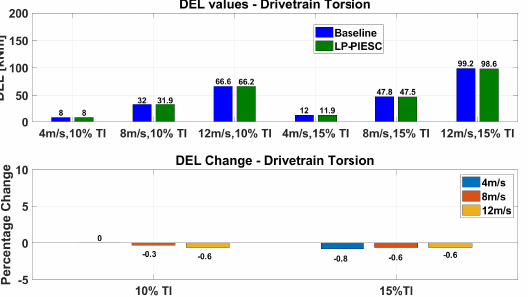
Figure 15. Drivetrain torsion comparison: Baseline vs. LP-PIESC. Aggregate DEL values with baseline controller and LP-PIESC ( top ), and percentage change in DEL ( bottom ) for time series from 300 s to 3000